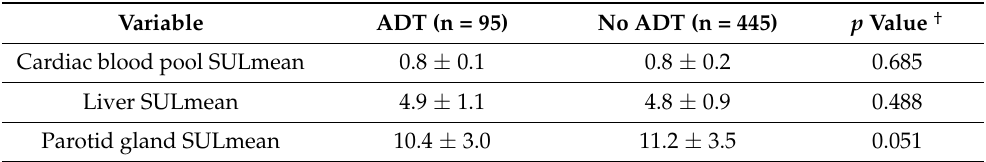
Table 3. Uptake characteristics of the normal organs in patients with/without ongoing ADT at the time of